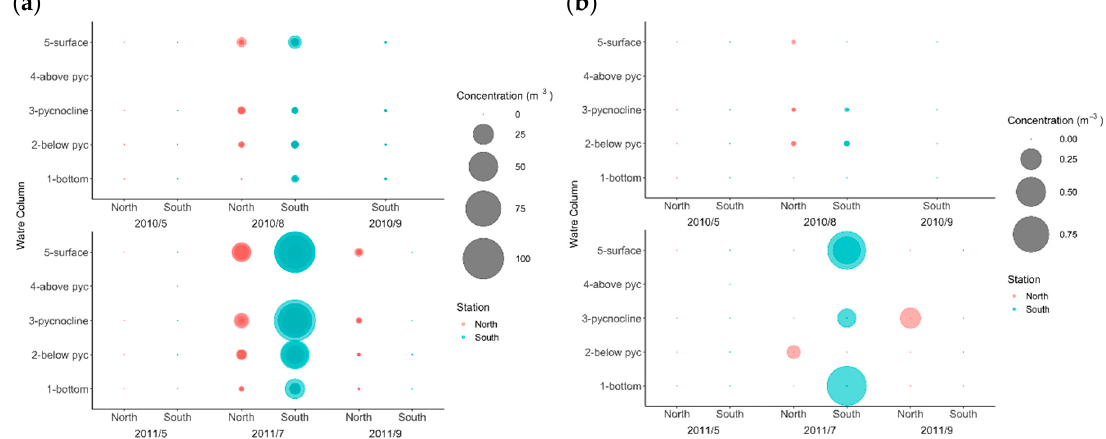
Figure 6. Concentrations of gelatinous zooplankton; comb jelly ( Mnemiopsis leidyi , ( a ) and bay nettle ( Chrysaora chesapeakei , ( b ) collected at North (red) and South (green) station during the six research cruises from May, August / July, September in 2010 and 2011. Bubble sizes indicate population sizes (ind. m − 3 ).